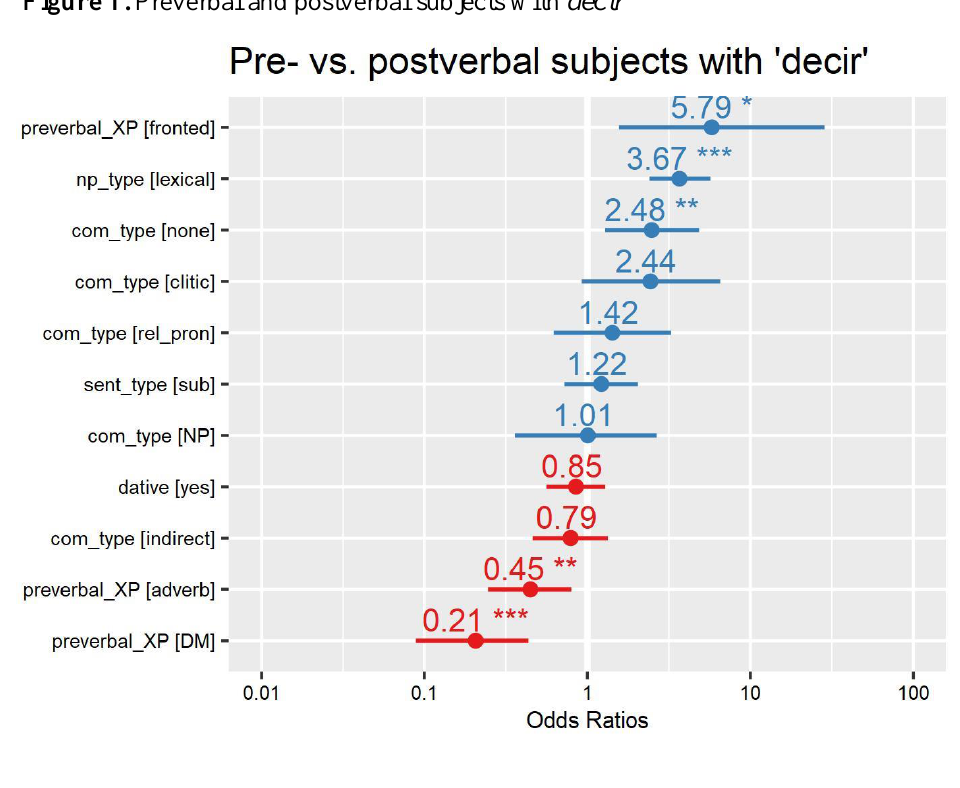
The figure has been generated by means of the sjPlot package (Lüdecke